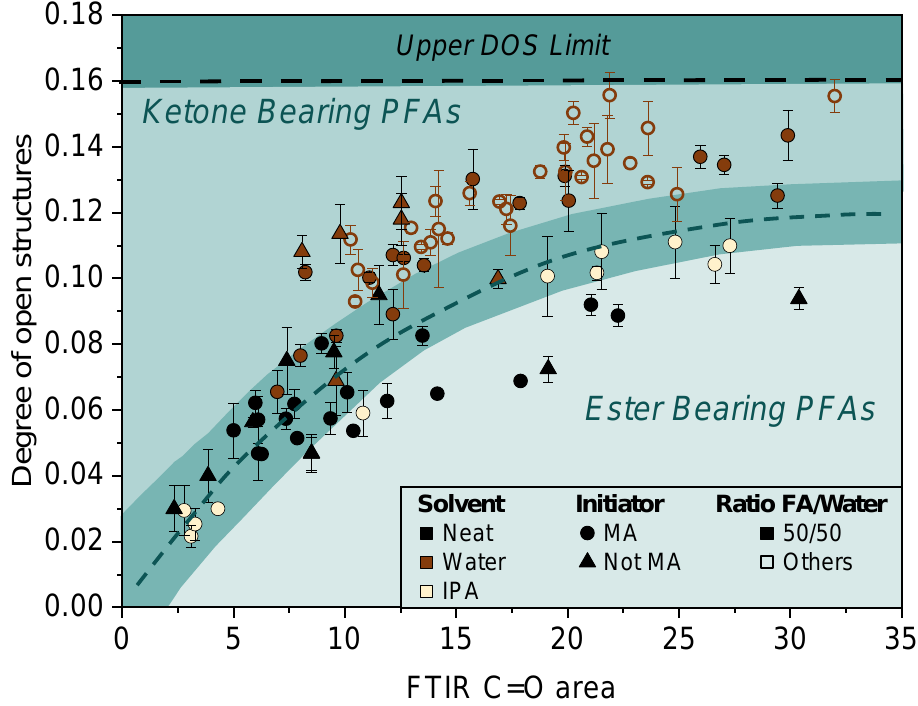
Figure 5. Degree of open structures obtained with titration method against FTIR C=O area for PFA synthetized in neat, aqueous and 50/50 IPA systems. PFA have been synthetized with aforementioned catalysts.